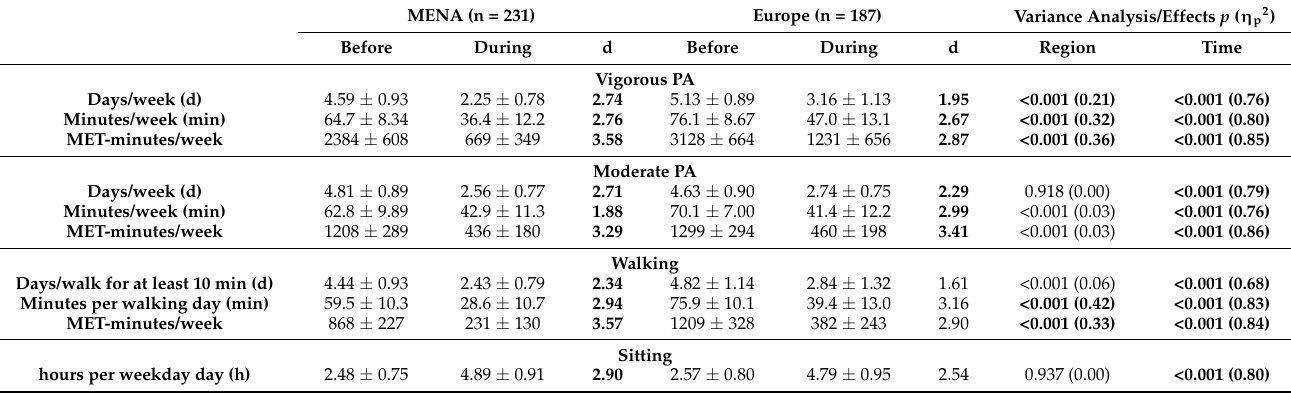
Table 3. Comparison of PA parameters between MENA region and Europe before and during confinement. Values are given as mean ± SD. Meaningful effects (criteria: p < 0.05 and η p2 > 0.10 and d > 0.8) highlighted in bold.